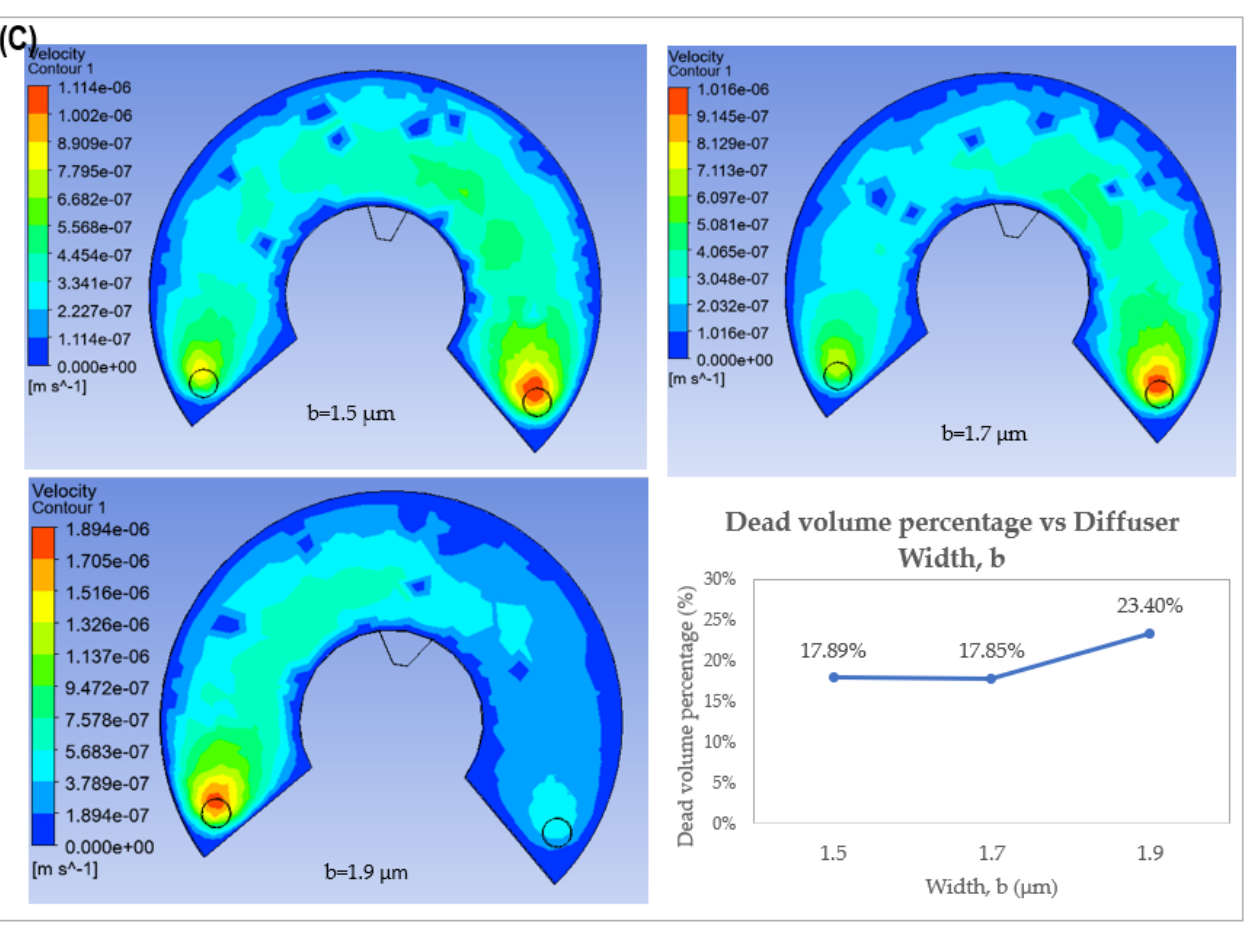
Figure 8. ( A ) Swelling process of one-unit hydrogel after applied single droplet water over time ( B ) Simulated result of storage chamber design optimization by varying ( B ) quantity of reservoir entrance port and ( C ) di ff user width.